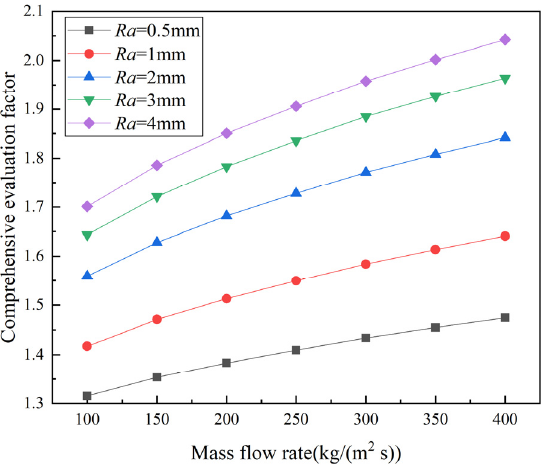
Figure 15. Comprehensive evaluation factor values of PCHEs at different mass flow rates for different curvature radii of inserted arc segments.